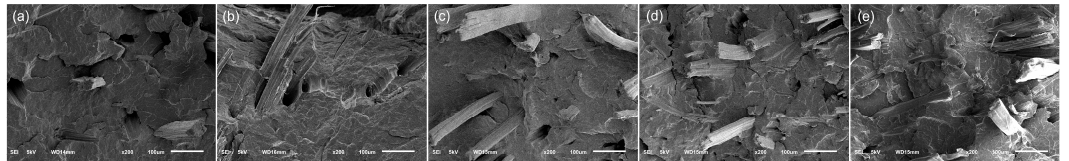
Figure 12. SEM images of the fracture surface of composites reinforced with ( a ) raw jute fibers, jute fibers pretreated at 100 ◦ C for ( b ) 3 and ( c ) 5 h, and jute fibers pretreated at 130 ◦ C for ( d ) 3 and ( e ) 5